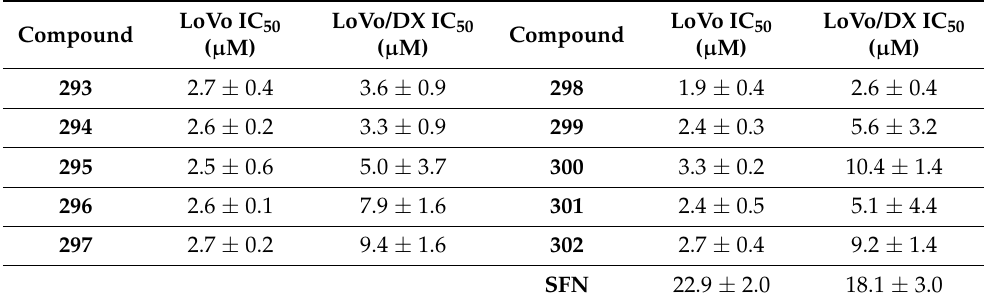
Table 9. Antiproliferative activity of isopropyl and isobutyl ω -(isothiocyanato)alkylphosphonates 293 – 302